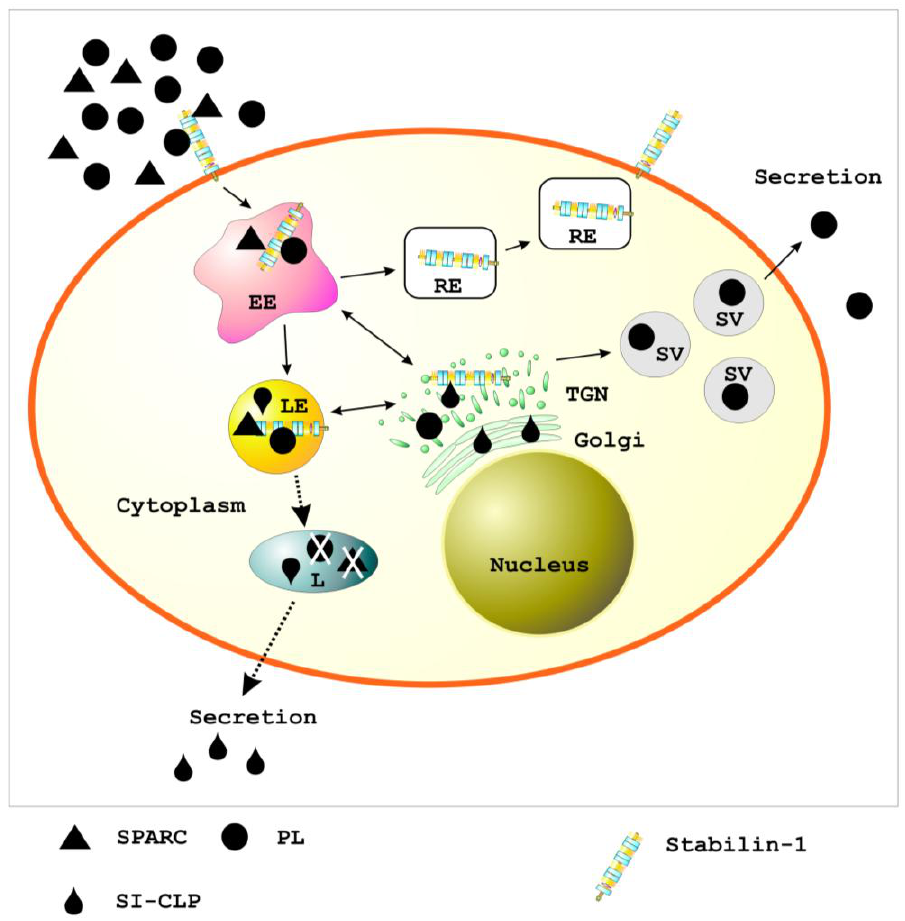
FIGURE 2 . Complex trafficking pathways of stabilin-1 and its ligands. Stabilin-1 recognizes extracellular endocytic ligands SPARC (shown as a filled triangles) and placental lactogen (PL) (shown as a filled circles), as well as newly synthesized intracellular sorting ligand SI-CLP (filled drops). Upon binding to the surface- expressed stabilin-1, endocytic ligands are internalized and delivered to early-sorting endosomes (EE). A portion of the ligand-free receptor can recycle back to the cell surface via recycling endosomes (RE). Stabilin-1 targets both SPARC and PL to late endosomes (LE), and consequently for the degradation in lysosomes (L). Part of PL escapes degradation and is delivered by stabilin-1 to the trans-Golgi network (TGN). In the TGN, PL dissociates from stabilin-1, is further transported to the new type of storage vesicles (SV), and can be secreted to the extracellular space. Stabilin-1 is also involved in the intracellular sorting process; it shuttles between endosomes and TGN. We propose a model whereby newly synthesized SI-CLP is recognized by stabilin-1 in the late Golgi compartment and delivered LE. In LE, SI-CLP dissociates from stabilin-1, is transported to the lysosomes, which further can undergo stimuli-dependent secretion (modified from Kzhyshkowska et